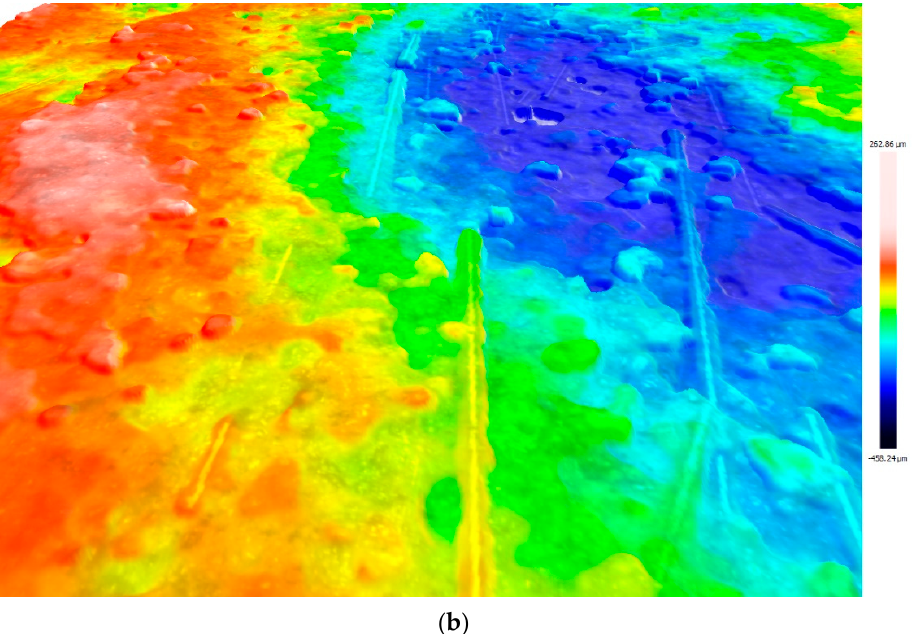
Figure 7. The structure of the carbon fiber reinforced composites: ( a ) structure of the composites and ( b ) surface profile.